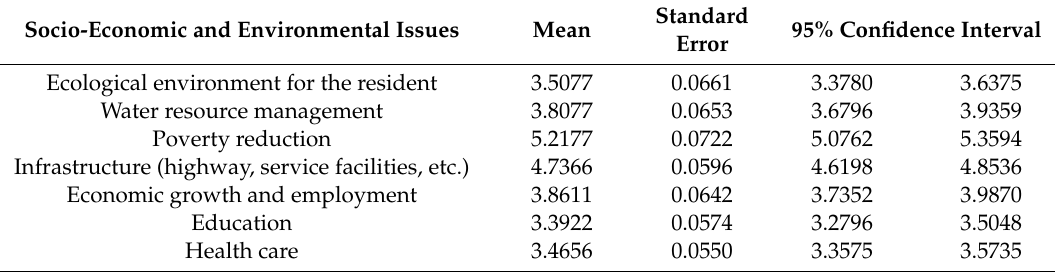
Table 3. Mean and standard errors of rankings for socio-economic and environmental